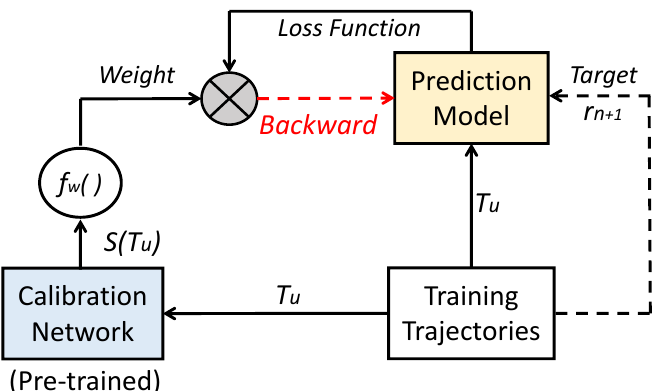
Figure 3. An overview of the trajectory quality calibration framework with a pre-trained calibration network to evaluate the data quality of training trajectories and integrate it into the parameter updating process of the main prediction